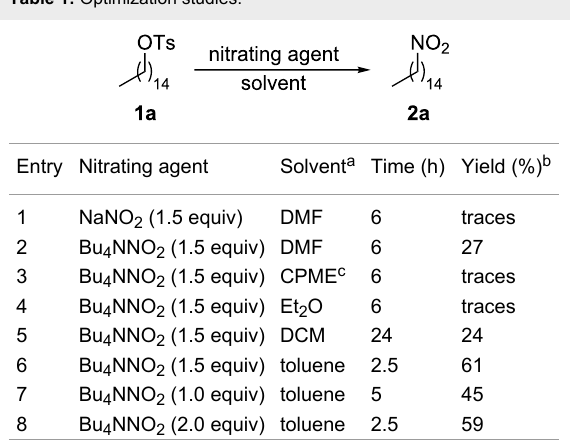
Table 1: Optimization studies.